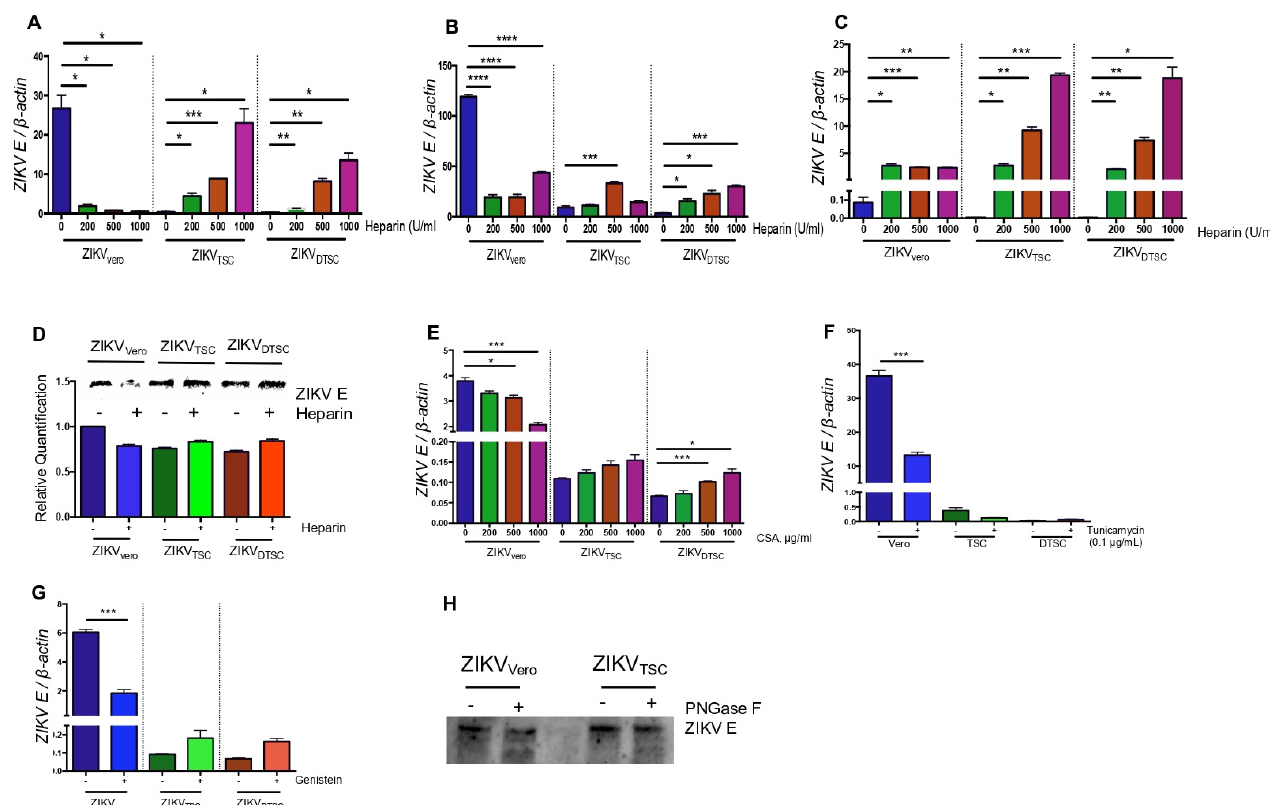
Figure 4. ZIKV grown in TSCs and DTSCs has reduced glycosylation. ( A ) Vero cells were pre-treated with heparin at different concentrations for 1 h, then 1 MOI of ZIKV Vero , ZIKV TSC , or ZIKV DTSC, and incubated at 4 ◦ C for 1 h. After washes, the attached viruses were quantified with qPCR. ( B ) Vero cells were pre-treated with heparin at different concentrations for 1 h, then inoculated with 1 MOI of ZIKV Vero , ZIKV TSC , or ZIKV DTSC and incubated at 37 ◦ C for 24 h, and the ratio of ZIKV to cellular β -actin was determined by qPCR. ( C ) ZIKV Vero , ZIKV TSC , or ZIKV DTSC were pre-incubated with heparin at 37 ◦ C for 1 h. Then, the mixture of the virus and heparin was added to Vero cell culture (1 MOI) and kept at 4 ◦ C for 1 h, and the cell-attached viruses were quantified by qPCR. ( D ) ZIKV Vero , ZIKV TSC , and ZIKV DTSC (1 × 10 5 PFU) were mixed with heparin-conjugated sepharose beads or unconjugated sepharose beads as control and kept at 4 ◦ C for 1 h. After washing, viruses bound to the beads were lysed and analyzed for ZIKV E by an immunoblotting assay (upper panel). The relative quantification of the blots is expressed in bar graphs in the lower panel. ( E ) Vero cells were pre-treated with different concentrations of chondroitin sulfate A (CSA) for 1 h and incubated with 1 MOI of ZIKV Vero , ZIKV TSC , or ZIKV DTSC at 4 ◦ C for 1 h. After washes, the attached viruses were quantified with qPCR. ( F ) Vero cells, TSCs, and DTSCs were infected with ZIKV (1 MOI) in the presence or absence of tunicamycin. On 24 h p.i., the viral replication was quantified by measuring the ratio of ZIKV E to cellular β -actin with qPCR. ( G ) Vero cells were incubated with 1 MOI of ZIKV Vero , ZIKV TSC , or ZIKV DTSC in the presence or absence of genistein at 4 ◦ C for 1 h. After washes, the attached viruses were quantified with qPCR. ( H ) The stocks of ZIKV Vero , ZIKV TSC , and ZIKV DTSC were pelleted by ultracentrifugation. The viruses were treated with PNGase F for deglycosylation and then analyzed with immunoblotting for ZIKV. The results were analyzed by either one-way ANOVA followed by Tukey’s test ( A – C , E ) or a two-tailed Student’s t -test ( F , G ). The results are representative of at least two independent experiments and are expressed as mean ± SEM. *, **, ***, and **** denote p < 0.05, p < 0.01, p < 0.001, and p < 0.0001,